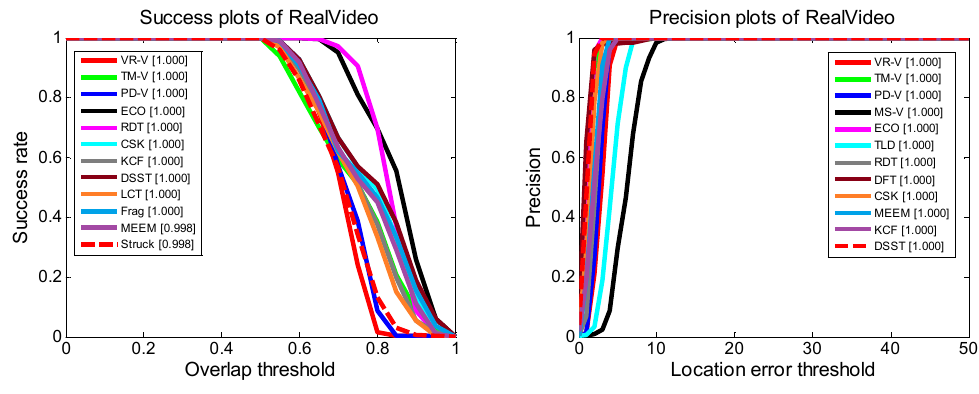
Figure 17. Success plots and precision plots of real infrared sequences.